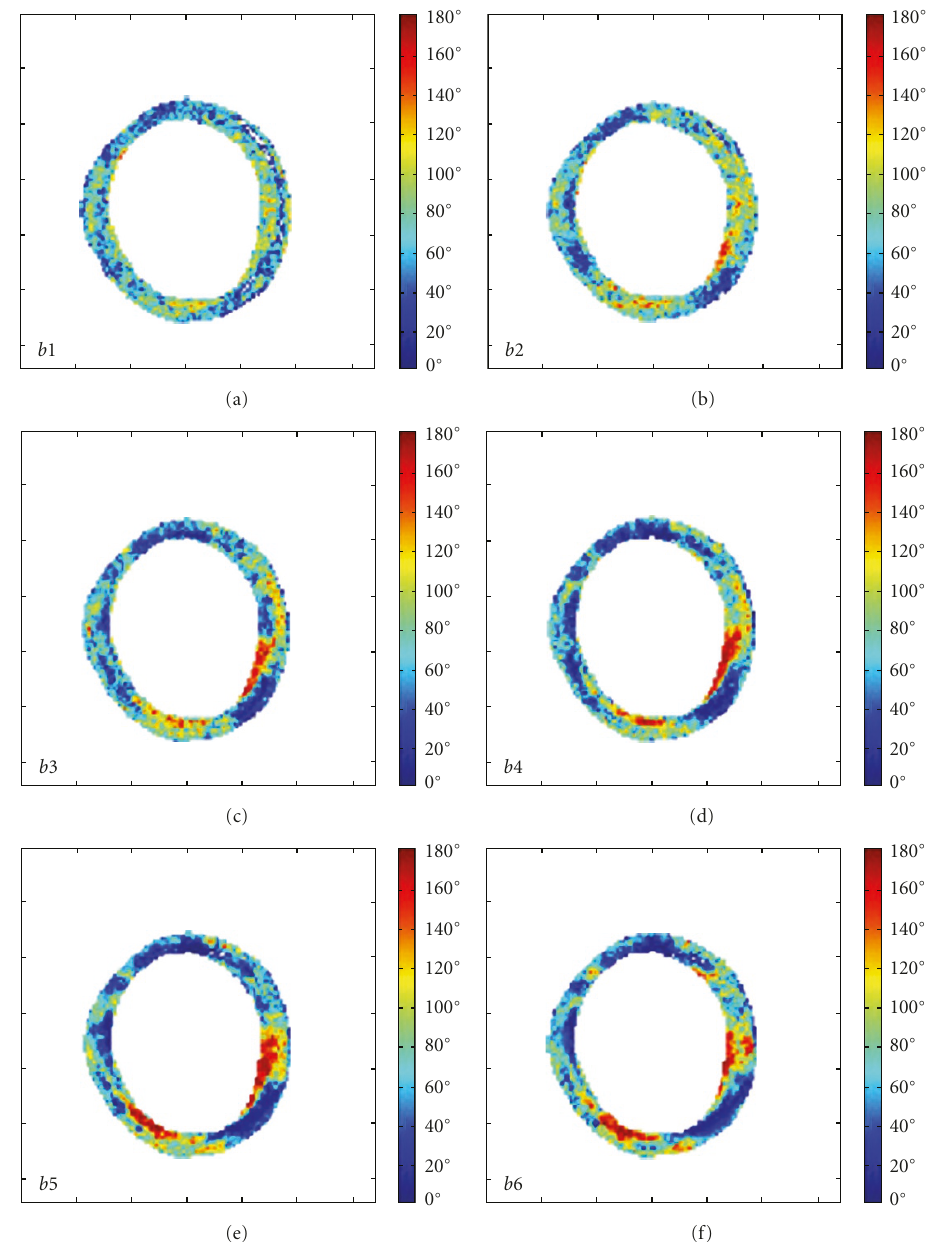
Figure 5: Contour maps of the angle between the first eigenvector and the x-y plane for the averaged tensors of the image data sets for the di ff erent b